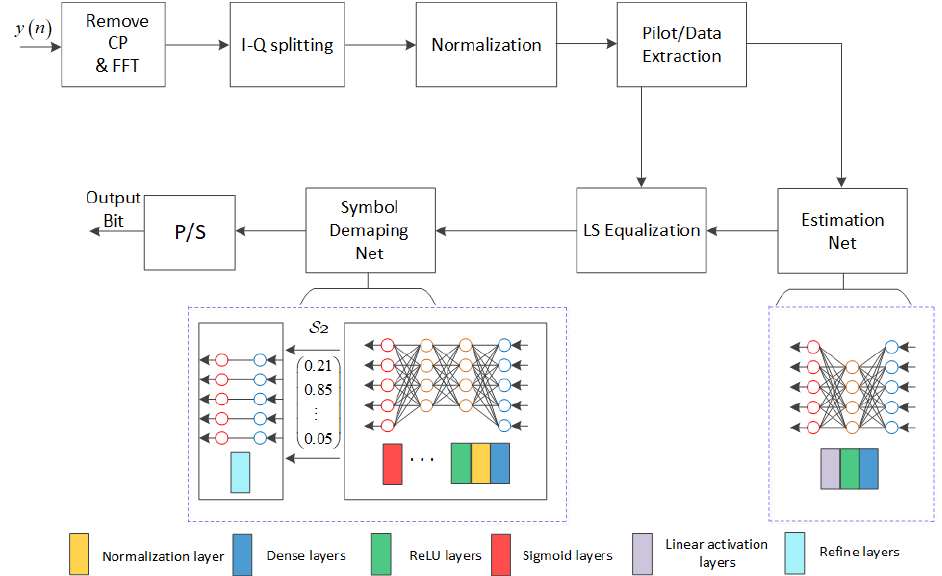
Figure 3. Diagram of the proposed DL-NPE scheme for the OFDM-based VLC